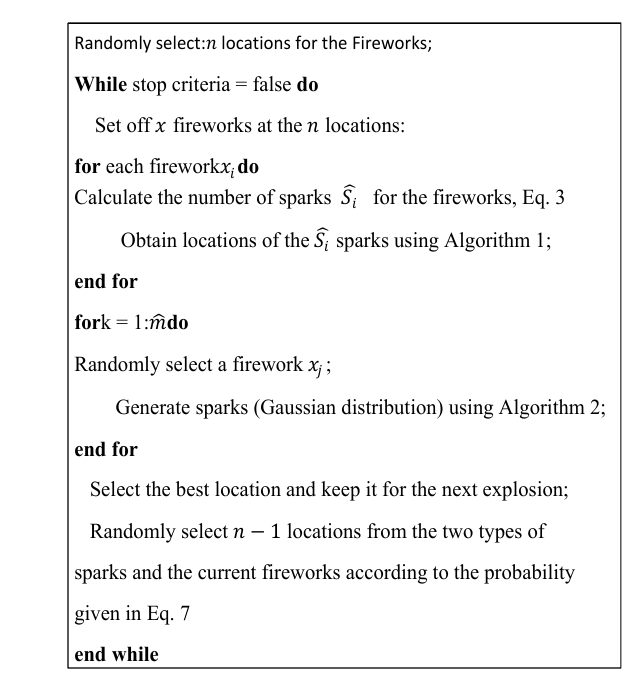
Figure 1. Pseudo code of Fireworks Algorithm (FWA).